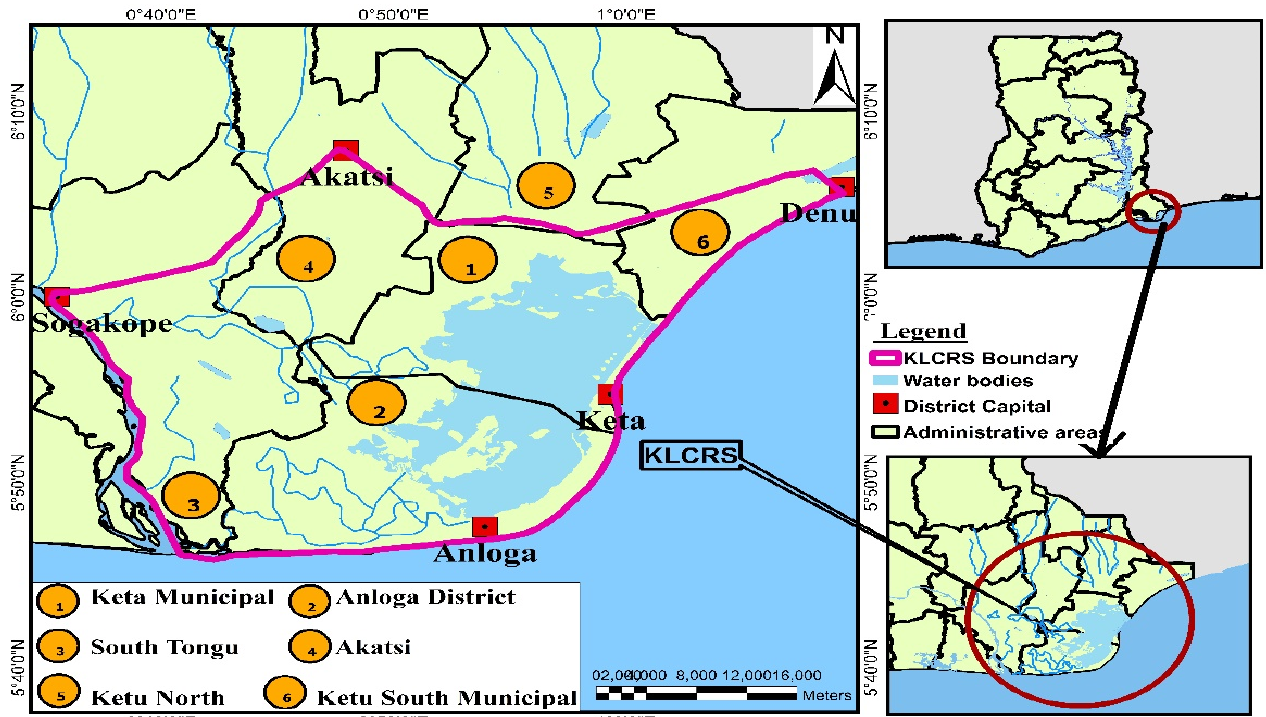
Figure 1. Map of the eastern coast of Ghana showing Keta Lagoon Complex and its surrounding floodplain, administrative areas, and district capitals.